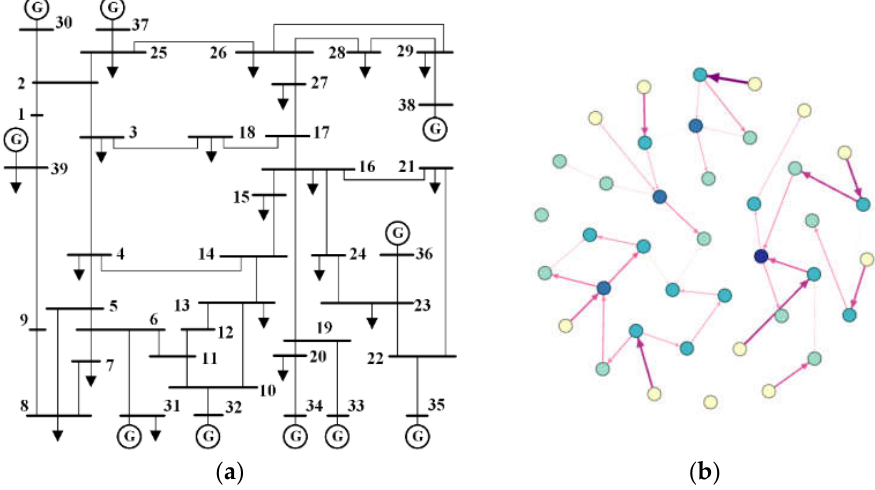
Figure 3. IEEE 39-node system: ( a ) IEEE 39-node system diagram and ( b ) IEEE 39-node system topological graph.